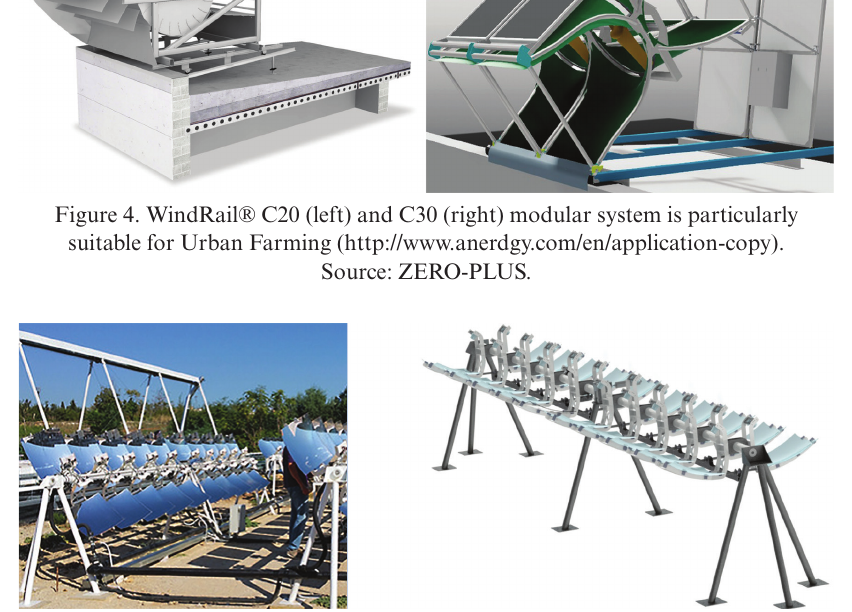
Figure 5. General view of HCPV-FAE tracker design FAE